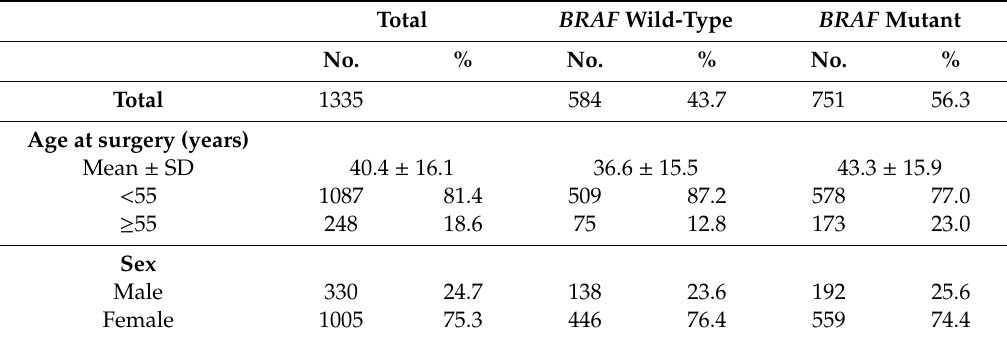
Table 1. Patient characteristics according to BRAF mutation